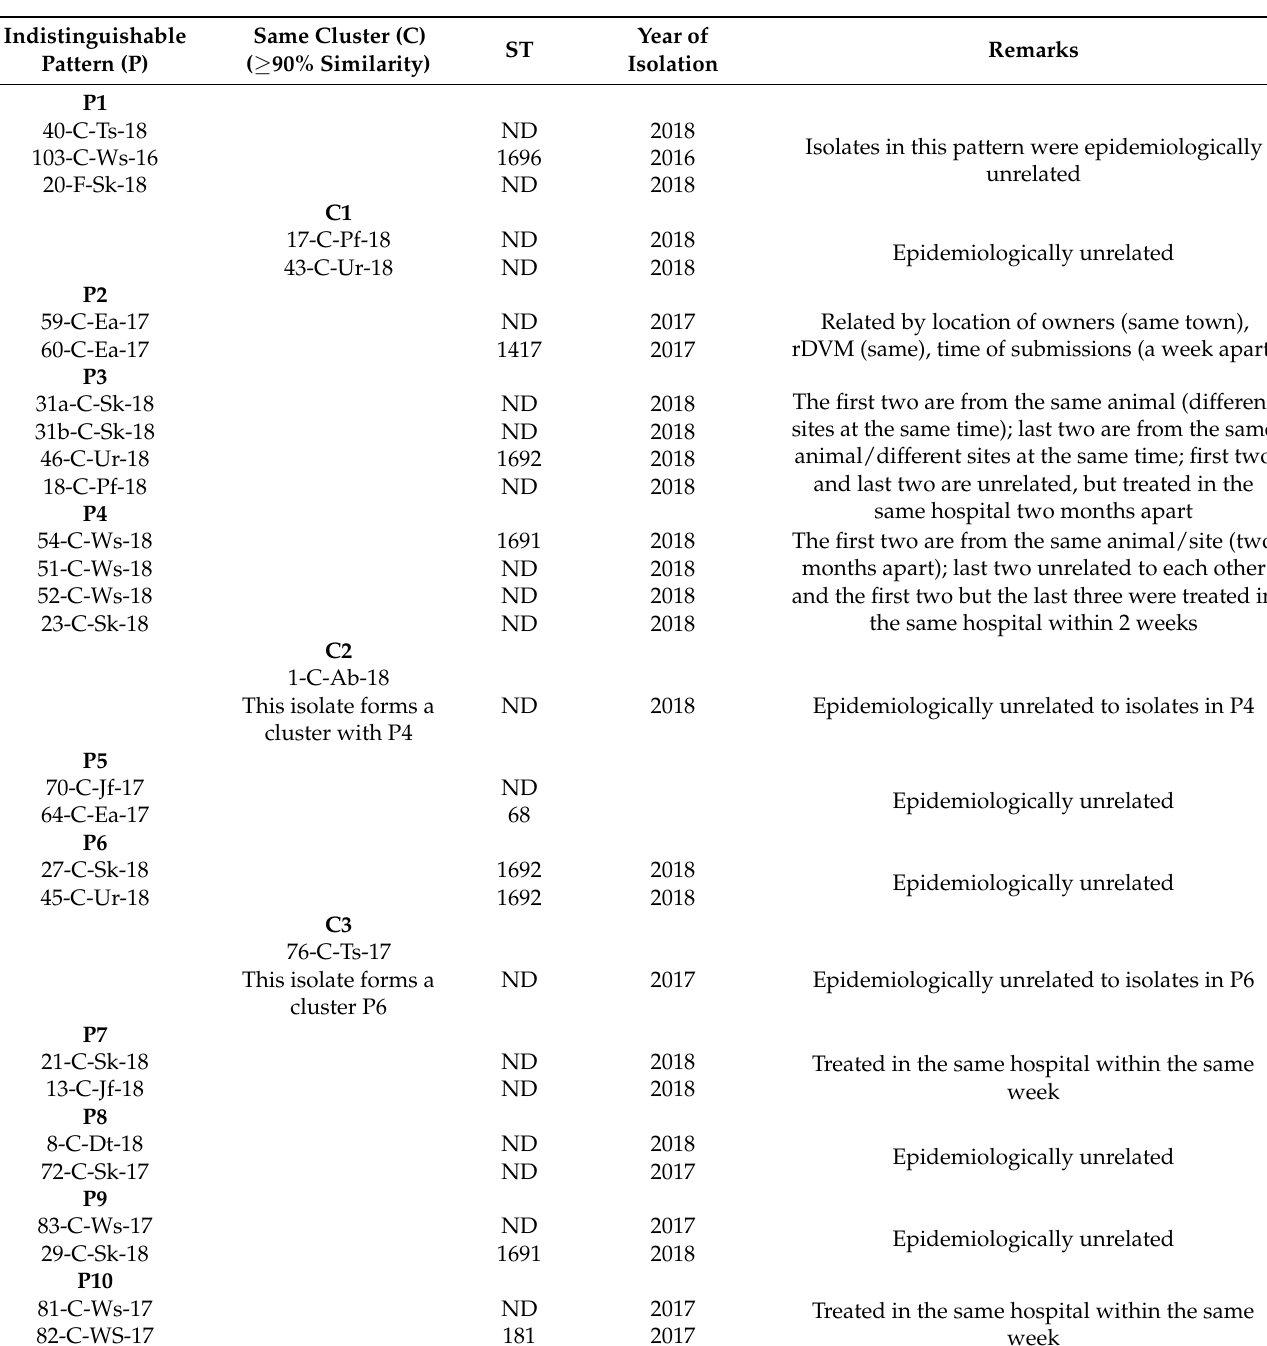
Table 5. Description of methicillin-resistant S. pseudintermedius (MRSP) isolates within the same PFGE patterns and/or main clusters